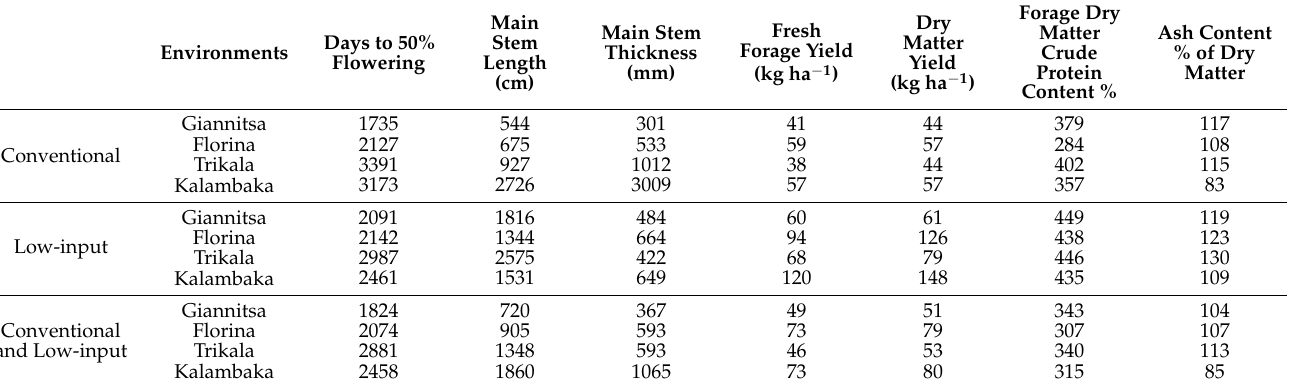
Table 2. Trait stability index across environments for two farming systems: days to 50% flowering,